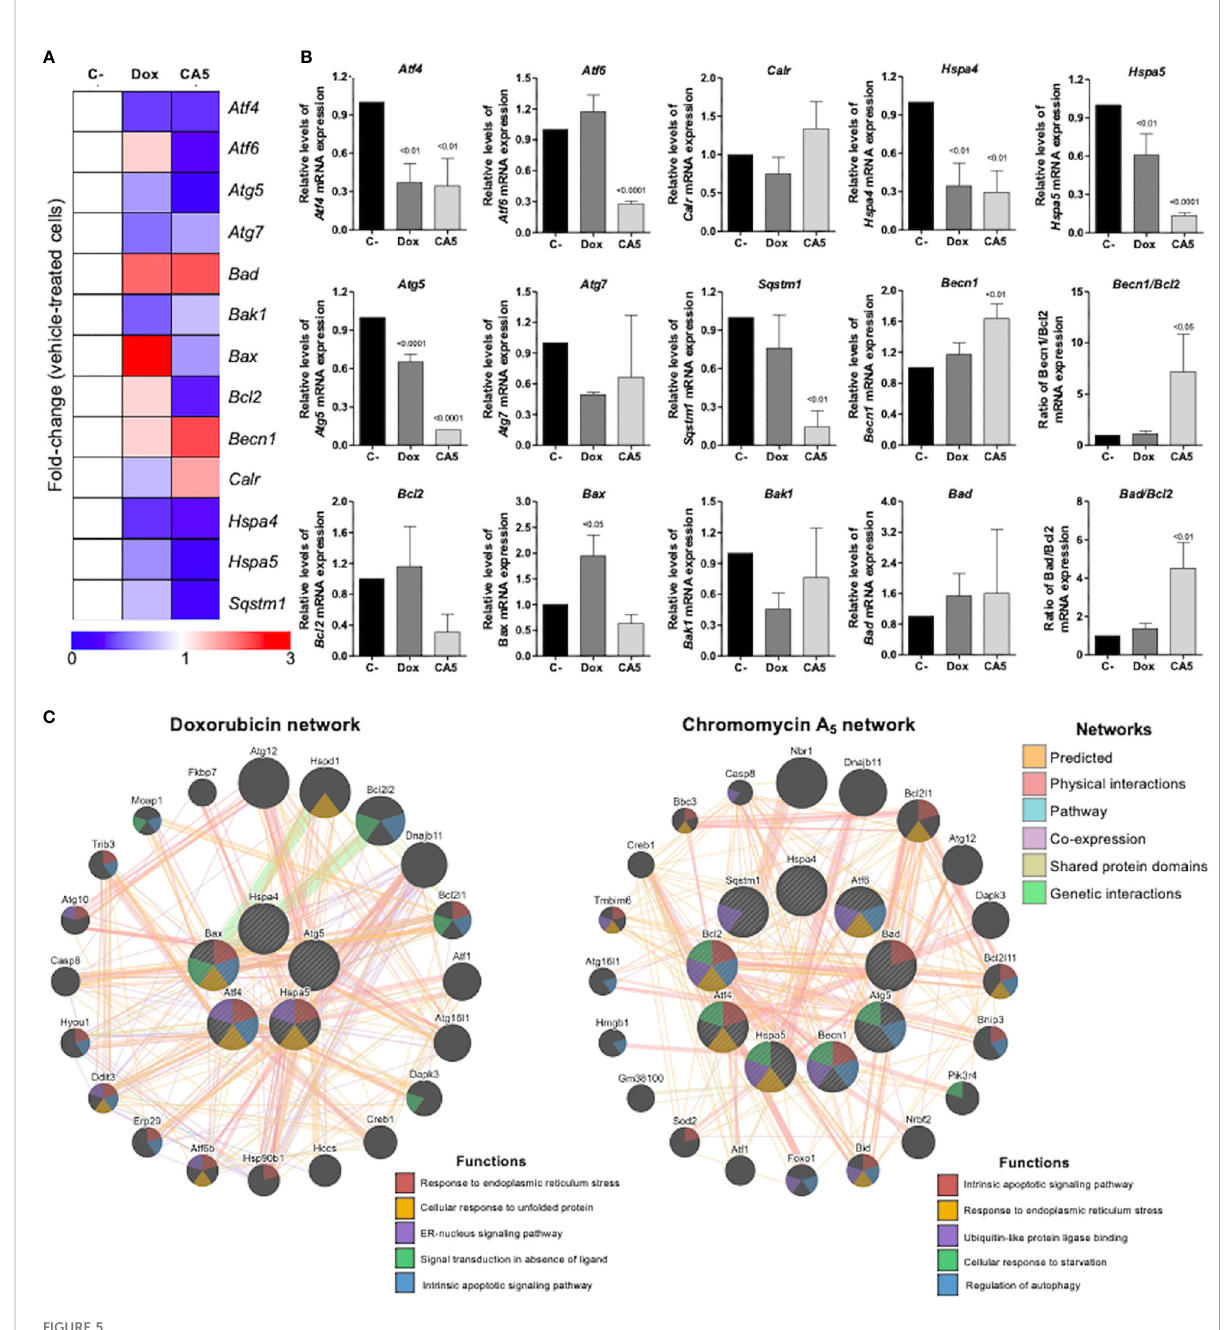
FIGURE 5 Chromomycin A 5 modulates transcription genes related to endoplasmic reticulum (ER) stress, autophagy, and cell death. Quantitative RT-PCR was performed for 13 selected genes related to ER stress ( Atf4 , Atf6 , Calr , Hspa4 , and Hspa5 ); autophagy ( Atg5 , Atg7 , Becn1 , and Sqstm1 ); and apoptosis ( Bad , Bak1 , Bax , and Bcl2 ). (A) Heatmap illustrating all selected genes in B16-F10 upon a vehicle, Dox (0.6 m M) or CA5 (0.1 m M) exposure for 24 h. The data are presented as fold-change of the vehicle-treated cells. Downregulated and upregulated genes are illustrated in blue and red, respectively. (B) The comparison of selected genes are presented in bar graphs and the p values are indicated. (C) Network analysis for genes modulated signi fi cantly by Dox or CA5 constructed using the GeneMANIA database (https://genemania.org/). The upregulated and downregulated genes in the quantitative RT-PCR are illustrated as strikethrough circles, and the interacting genes included by the software modeling are indicated by strikethrough strands. The main interactions between genes are indicated by colored lines and the fi ve main cellular processes are described in the